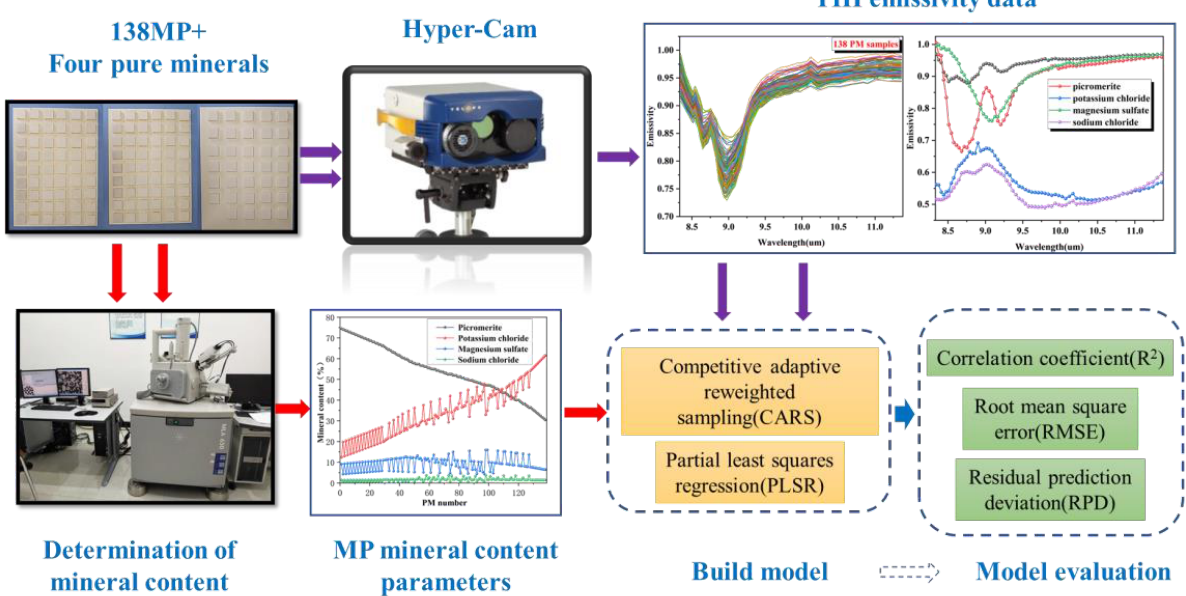
Figure 1. Schematic diagram of experimental and modeling